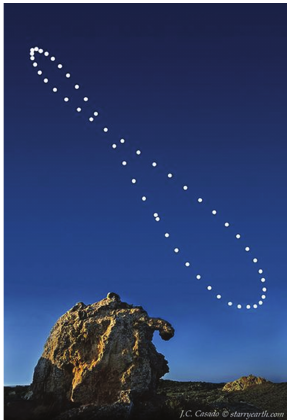
Figure 2: Solar annalema in Cabo de Creus (Gerona, Spain). Juan Carlos Casado: